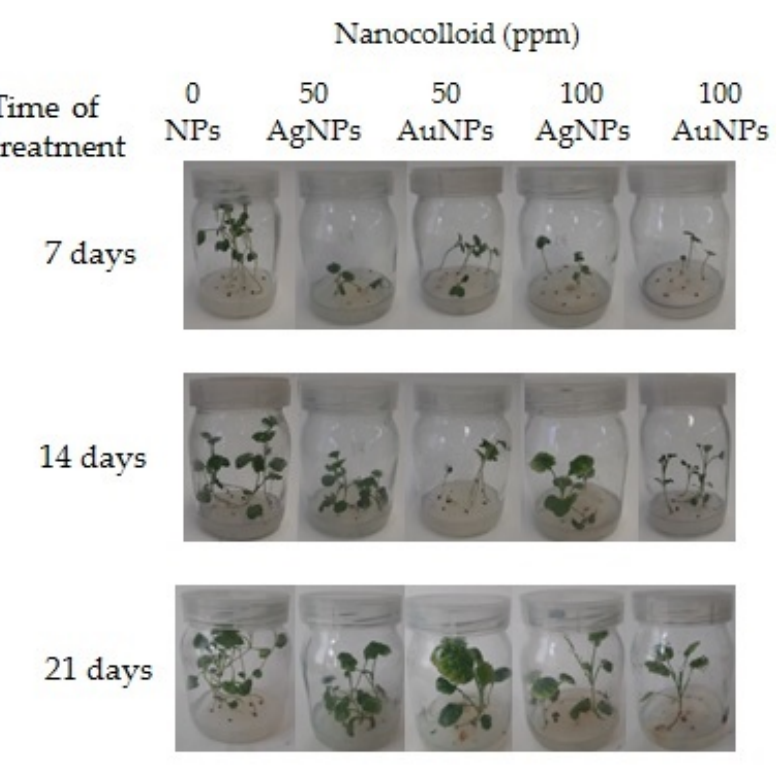
Figure 1. Comparison of the effect of the nanoparticles' (NPs) type and concentration on the mor- phological parameters of seedlings. Abbreviations: AgNPs—silver nanoparticles, AuNPs—gold na- noparticles.